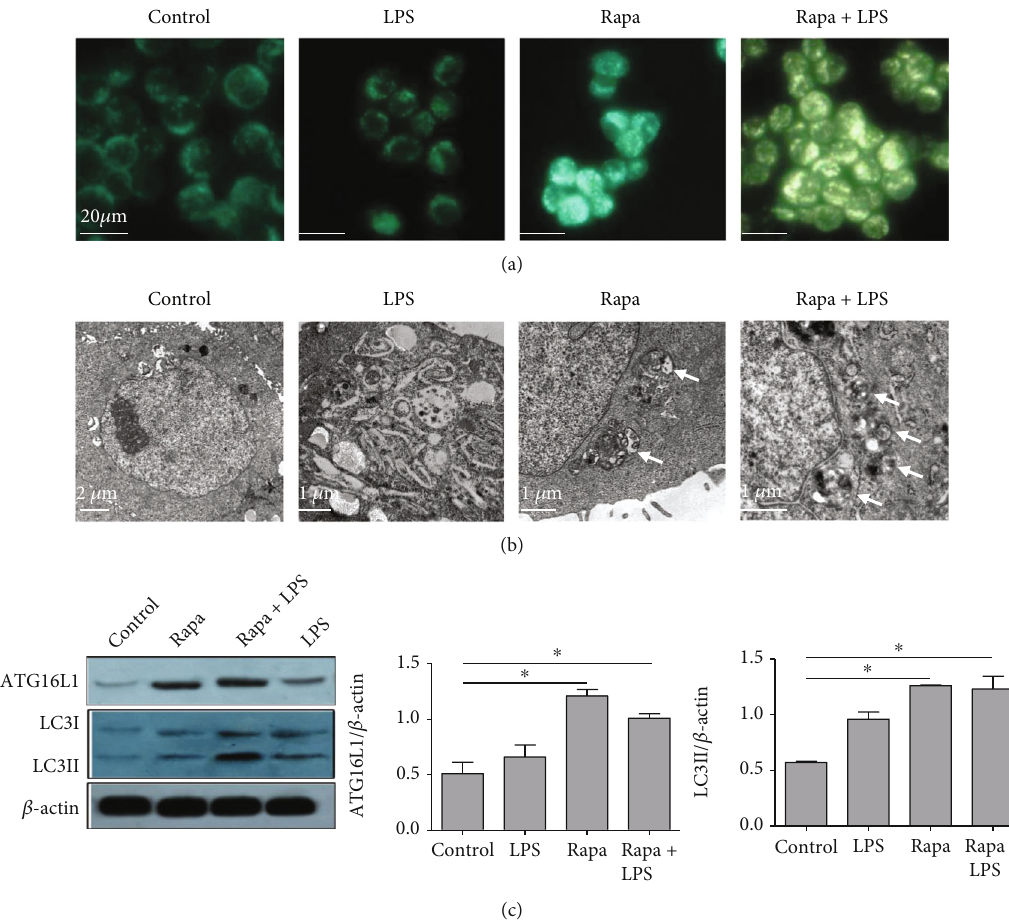
Figure 3: Rapamycin induces autophagy in vitro . HT-29 cells were stimulated by LPS (100ng/ml) with or without rapamycin (25 μ g/ml) pretreatment for 1h. (a) The formation of autophagic corpuscles in HT-29 cells were detected by MDC. (b) The intracellular autophagosomes were observed using electron microscopy (arrow). (c) The expression of ATG16L1, LC3I, and LC3II in HT-29 cells was detected by western blot n = 3 per group; ∗ P < 0 : 05